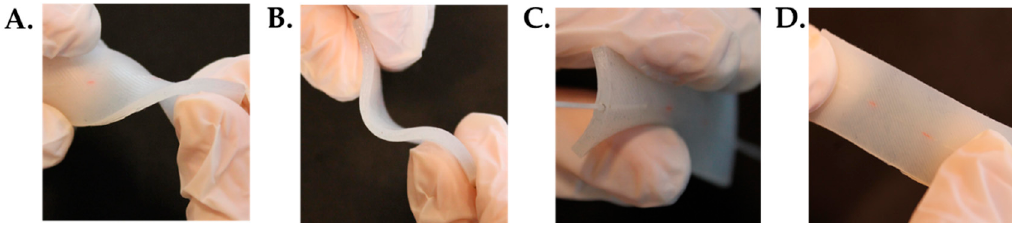
Figure 3. The flexible element in four different configurations: ( A ) twisting, ( B ) bending, ( C ) folding and ( D ) stretching.